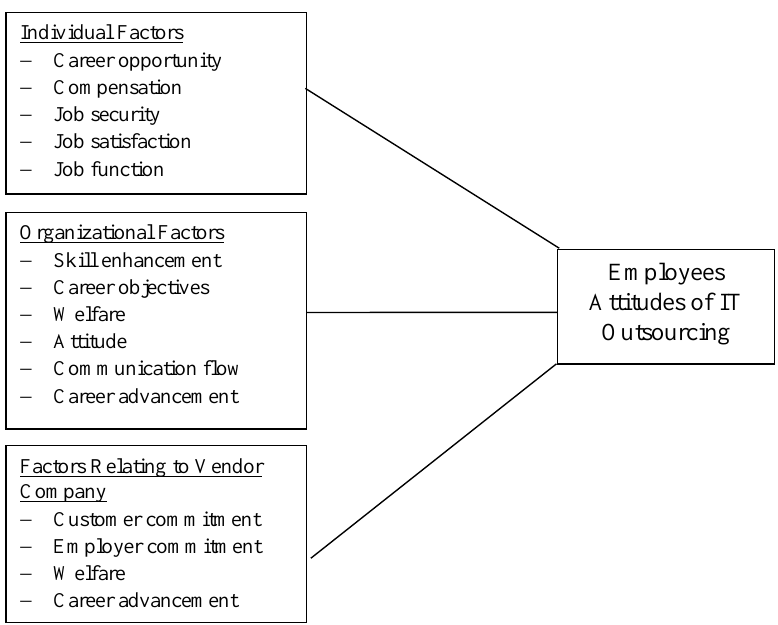
Figure 1: The research